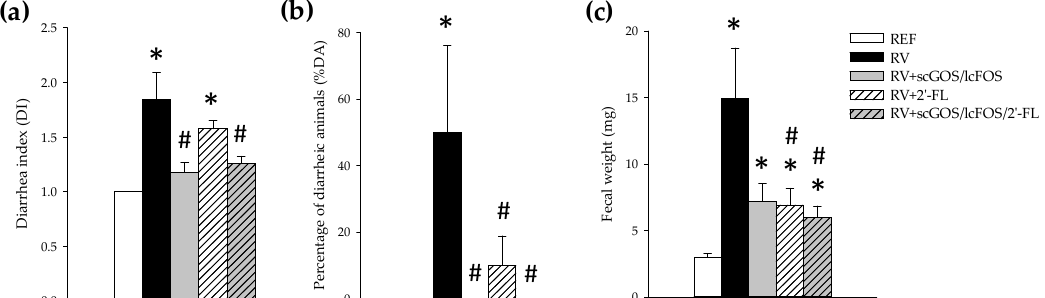
Figure 1. Clinical variables of severity and incidence of diarrhea on day 8: ( a ) The Diarrhea Index (DI) is based on scoring fecal samples from 1 to 4 depending on the color, texture, and abundance. Scores of DI ≥ 2 indicate the presence of diarrhea, whereas scores < 2 indicate the absence of diarrhea. ( b ) The percentage of diarrheic animals (%DA) is based on the percentage of animals displaying DI scores ≥ 2 in each group. ( c ) The mean fecal weight was calculated in each group as an objective indicator of diarrhea severity. The results are expressed as mean ± S.E.M. (n = 8–12 / group, depending on the number of fecal samples obtained) * p < 0.05 compared to the reference (REF) group; # p < 0.05 compared to the RV group ((a) by ANOVA; (b) by the Chi Squared test; and (c) by the Mann–Whitney U test).